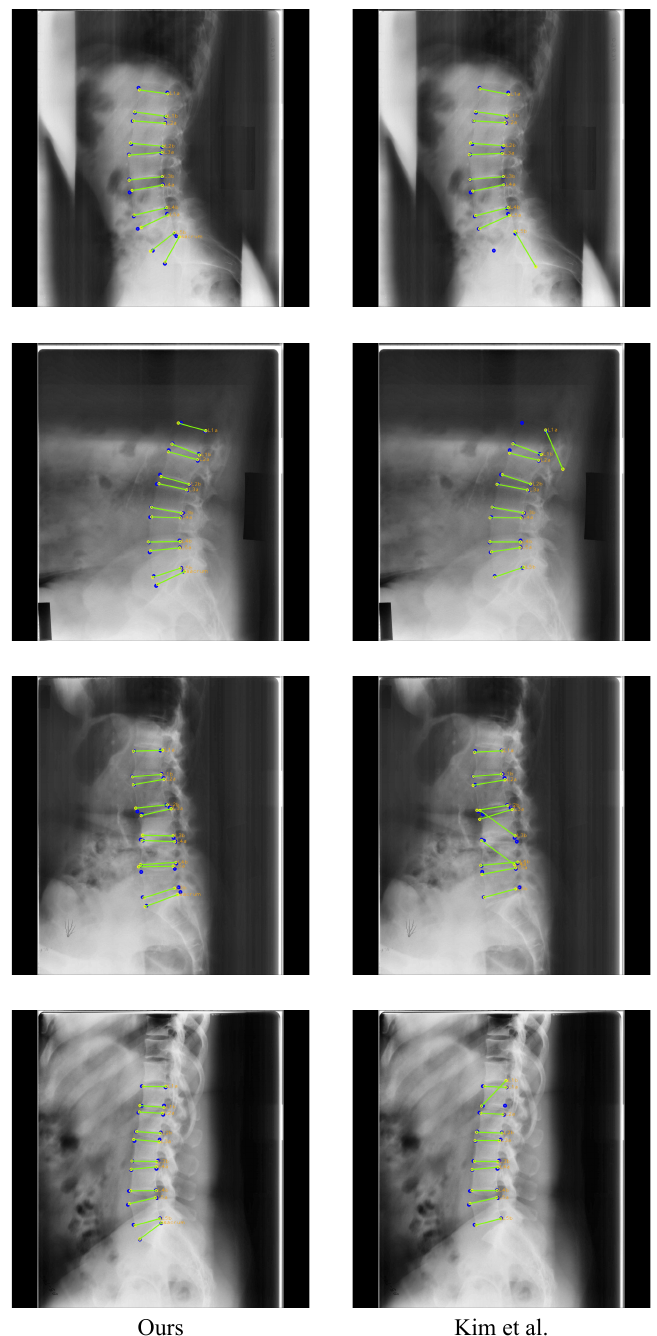
Figure 20. Example of landmark detection result of ours and Kim et al. [5]. The blue circles represent the ground truth, while yellow circles with labels represent predicted results, and the green lines represent the line connecting the predicted landmarks of an